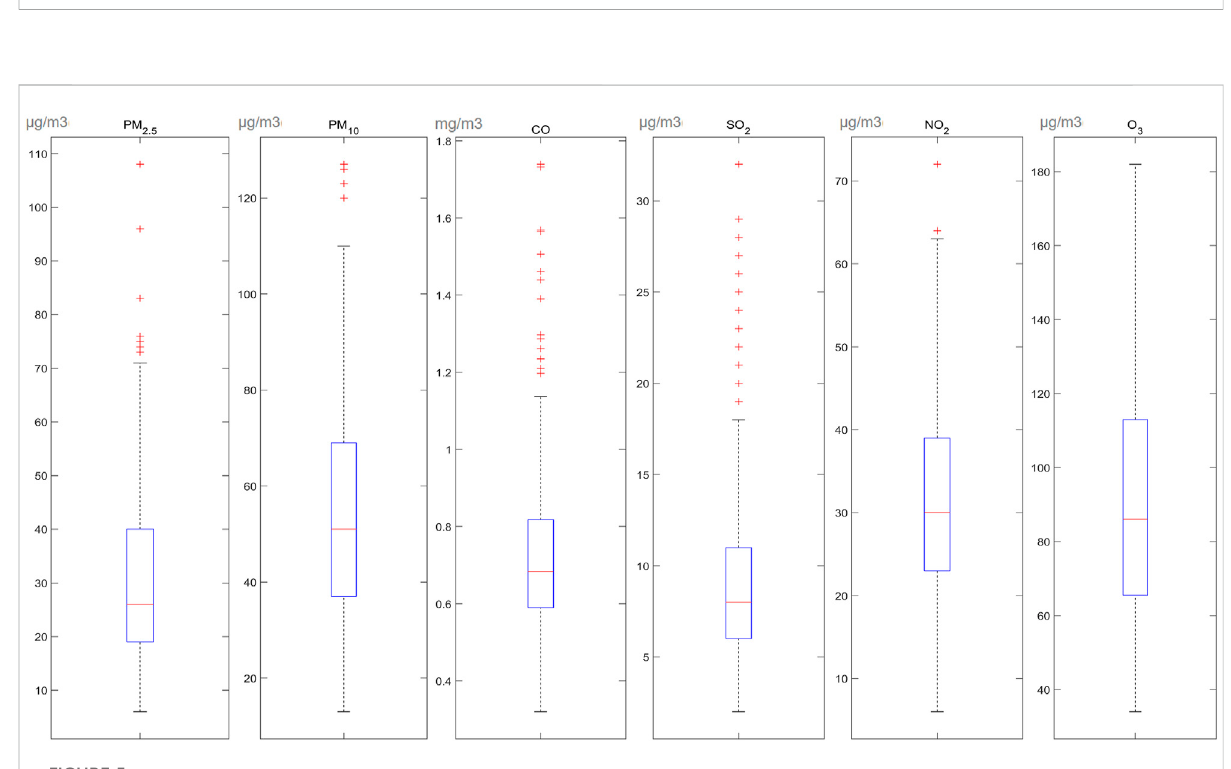
FIGURE 5 Distribution of concentrations for six criteria air